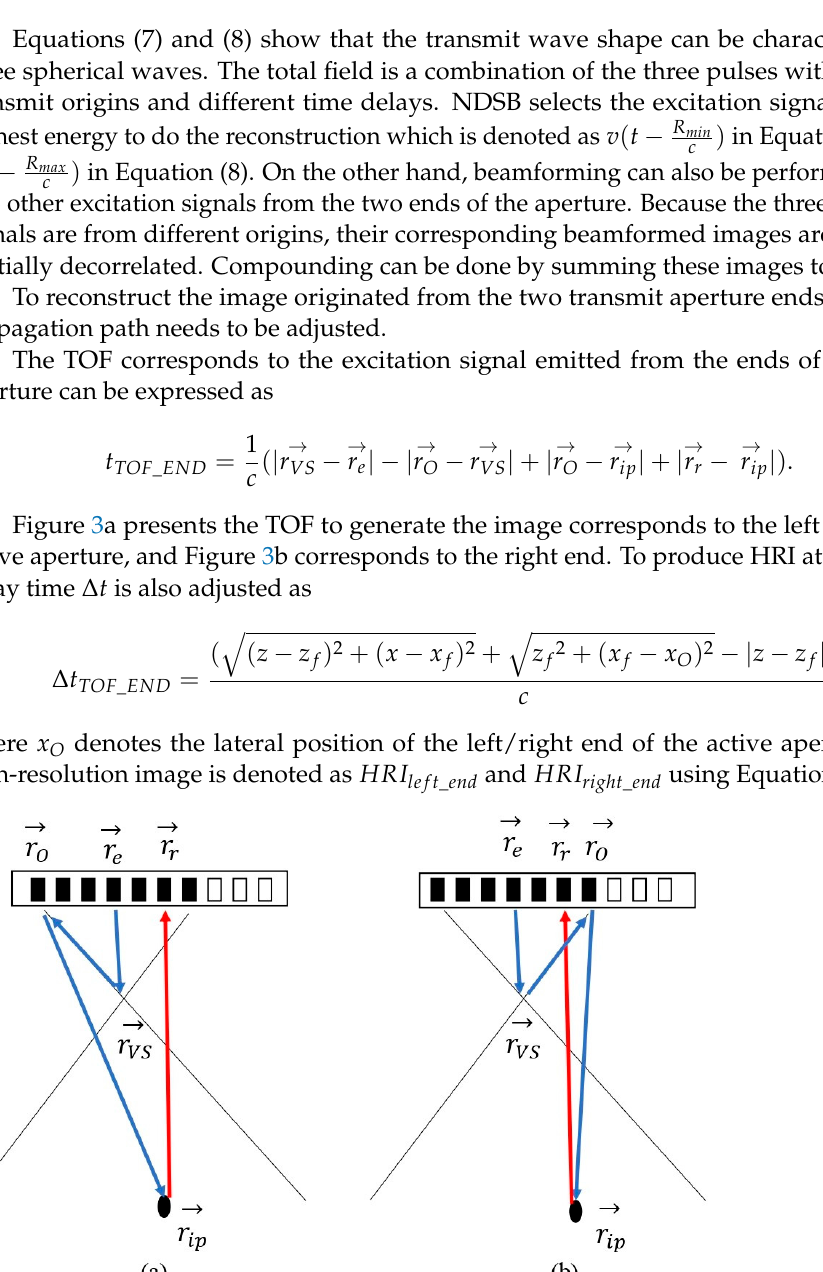
4 of 10 Figure 2. Geometries for calculating pressure field of transmit sub-aperture for spatial point 𝑃 in front of the focus ( a ) and behind the focus ( b ). Equations (7) and (8) show that the transmit wave shape can be characterized by